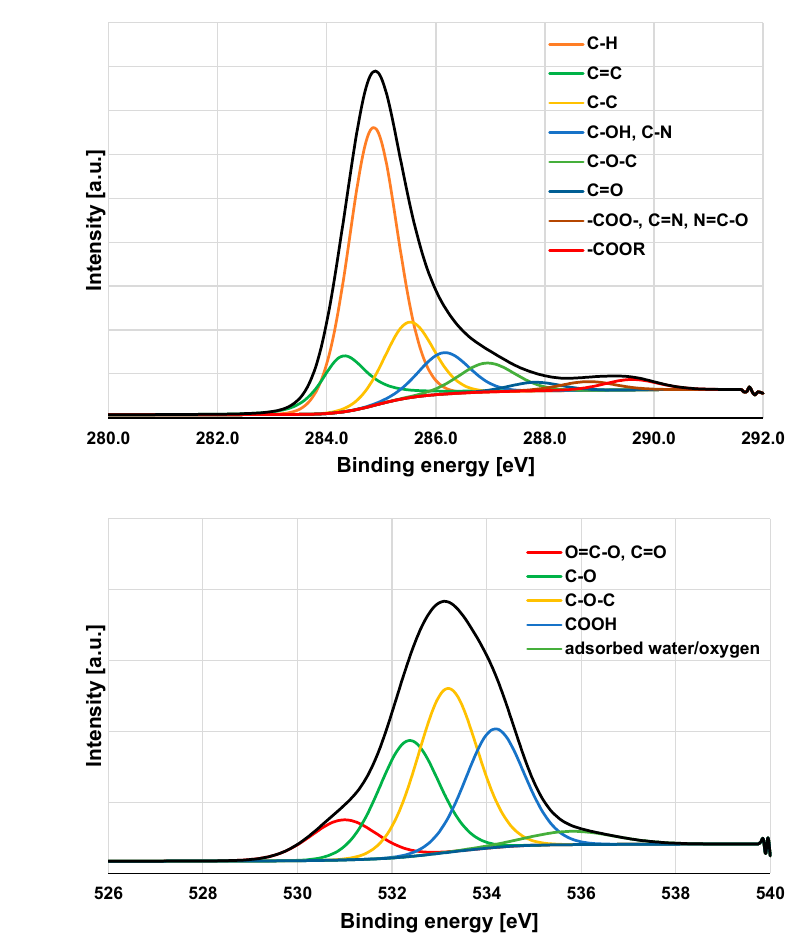
Figure 9. C 1s ( a ) and O 1s ( b ) spectra of NE–AC activated carbon before polymers adsorption.